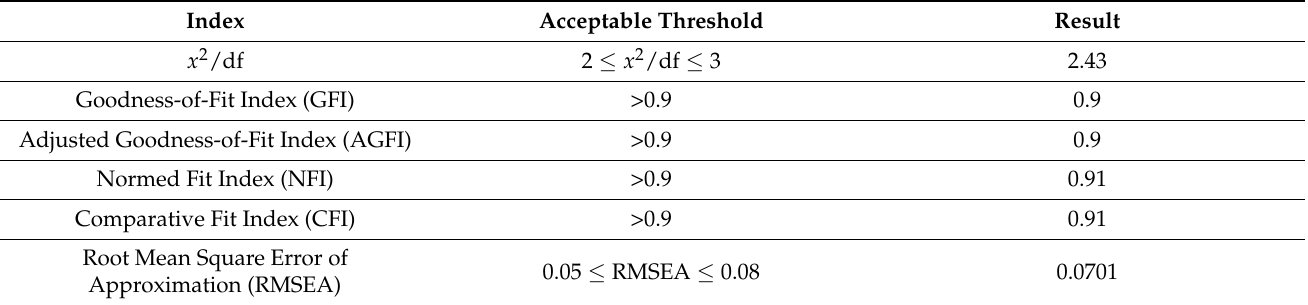
Table 10. The results of model goodness-of-fit indexes.